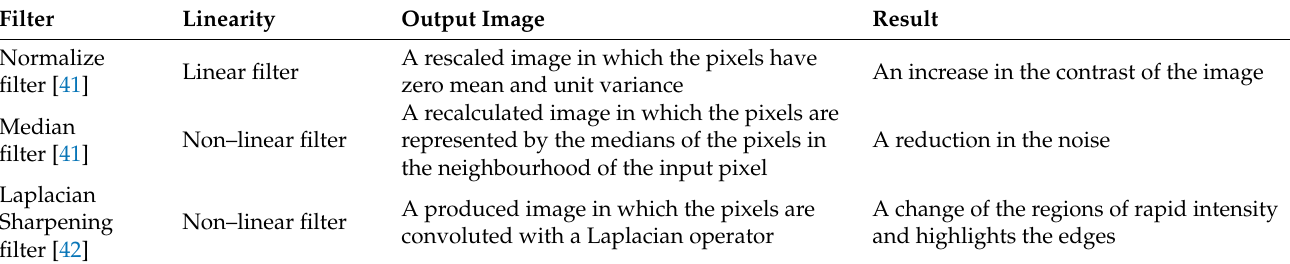
Table 1. The comparison of details (linearity of the filter, type of output image, and result of filtering) of three filtering algorithms (Normalize filter, Median filter, and Laplacian Sharpening filter) used in the